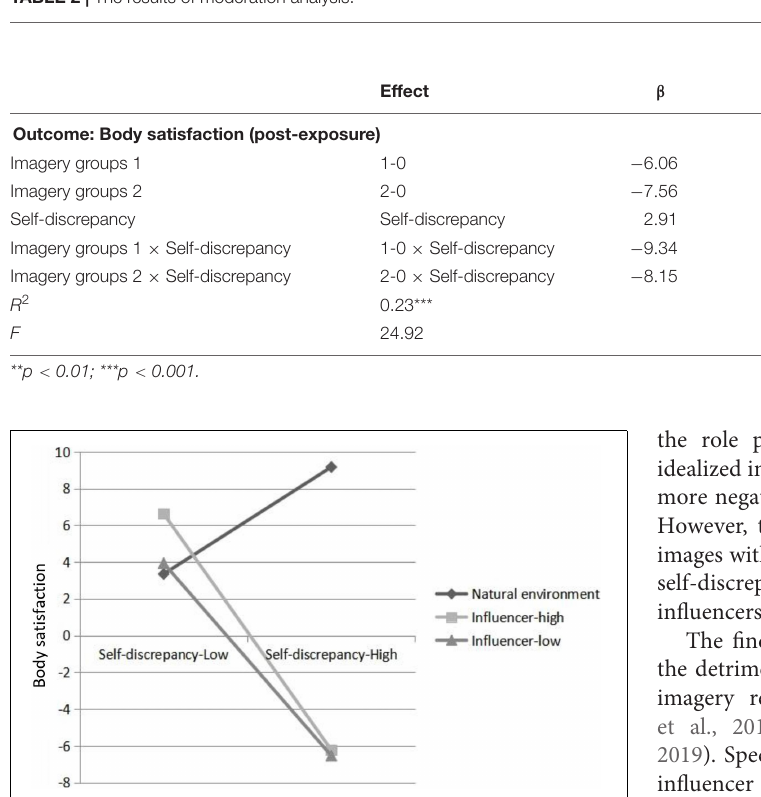
satisfaction varies with the degree of an individual’s self-